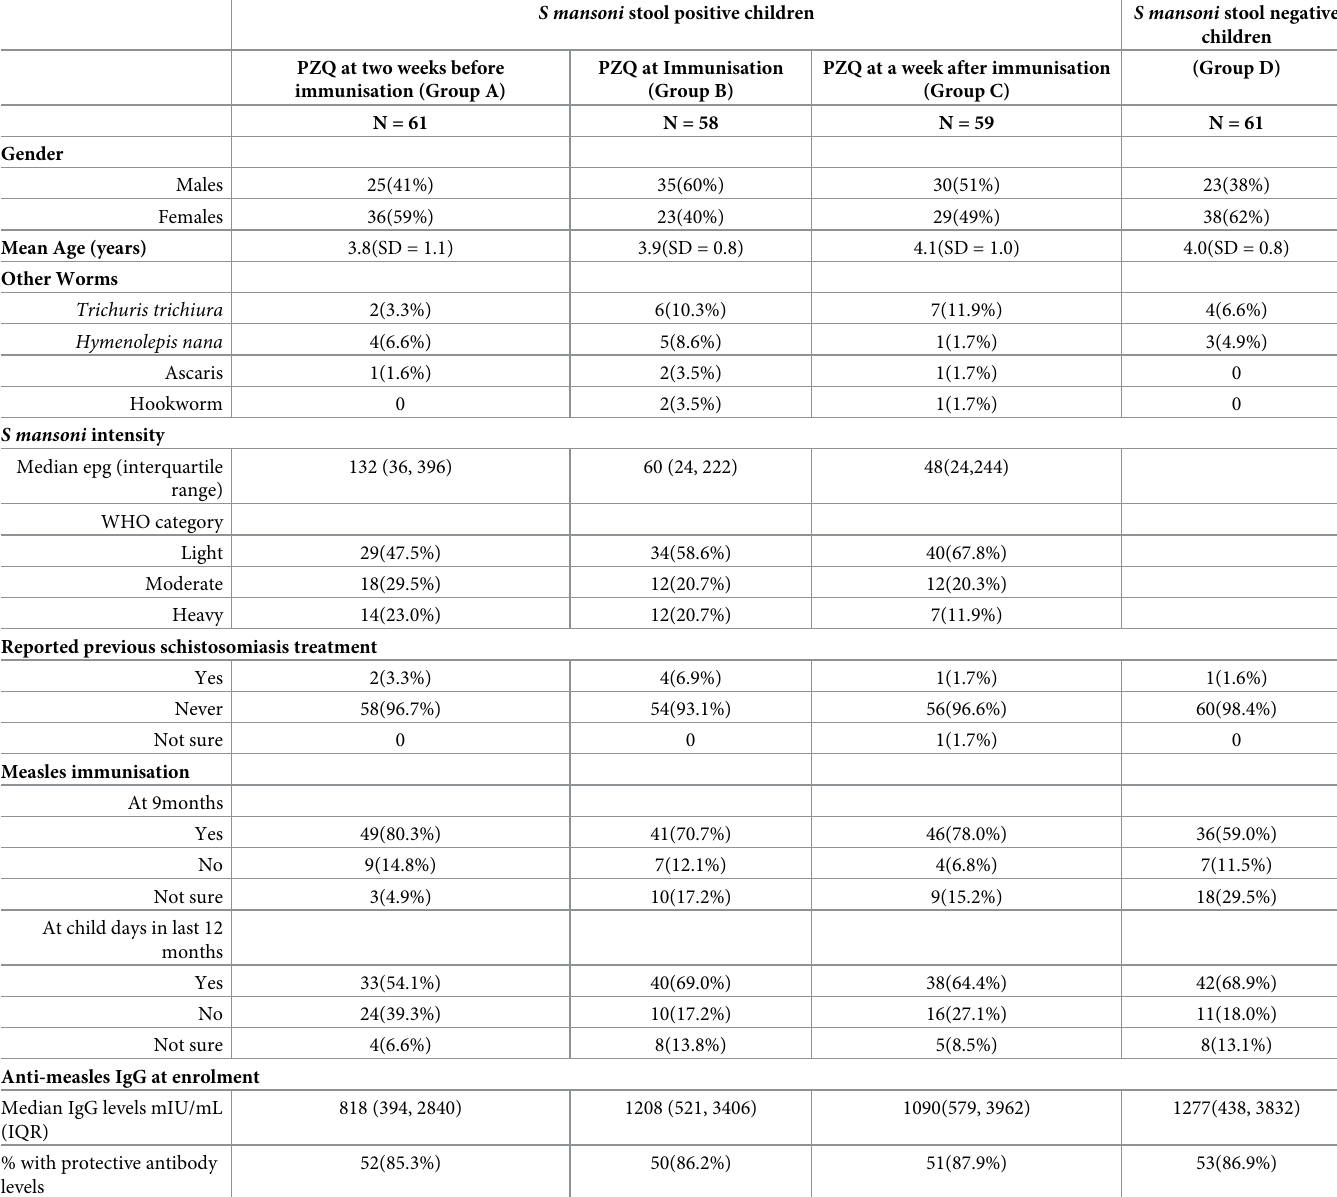
Table 1. Baseline and demographic characteristics of the study